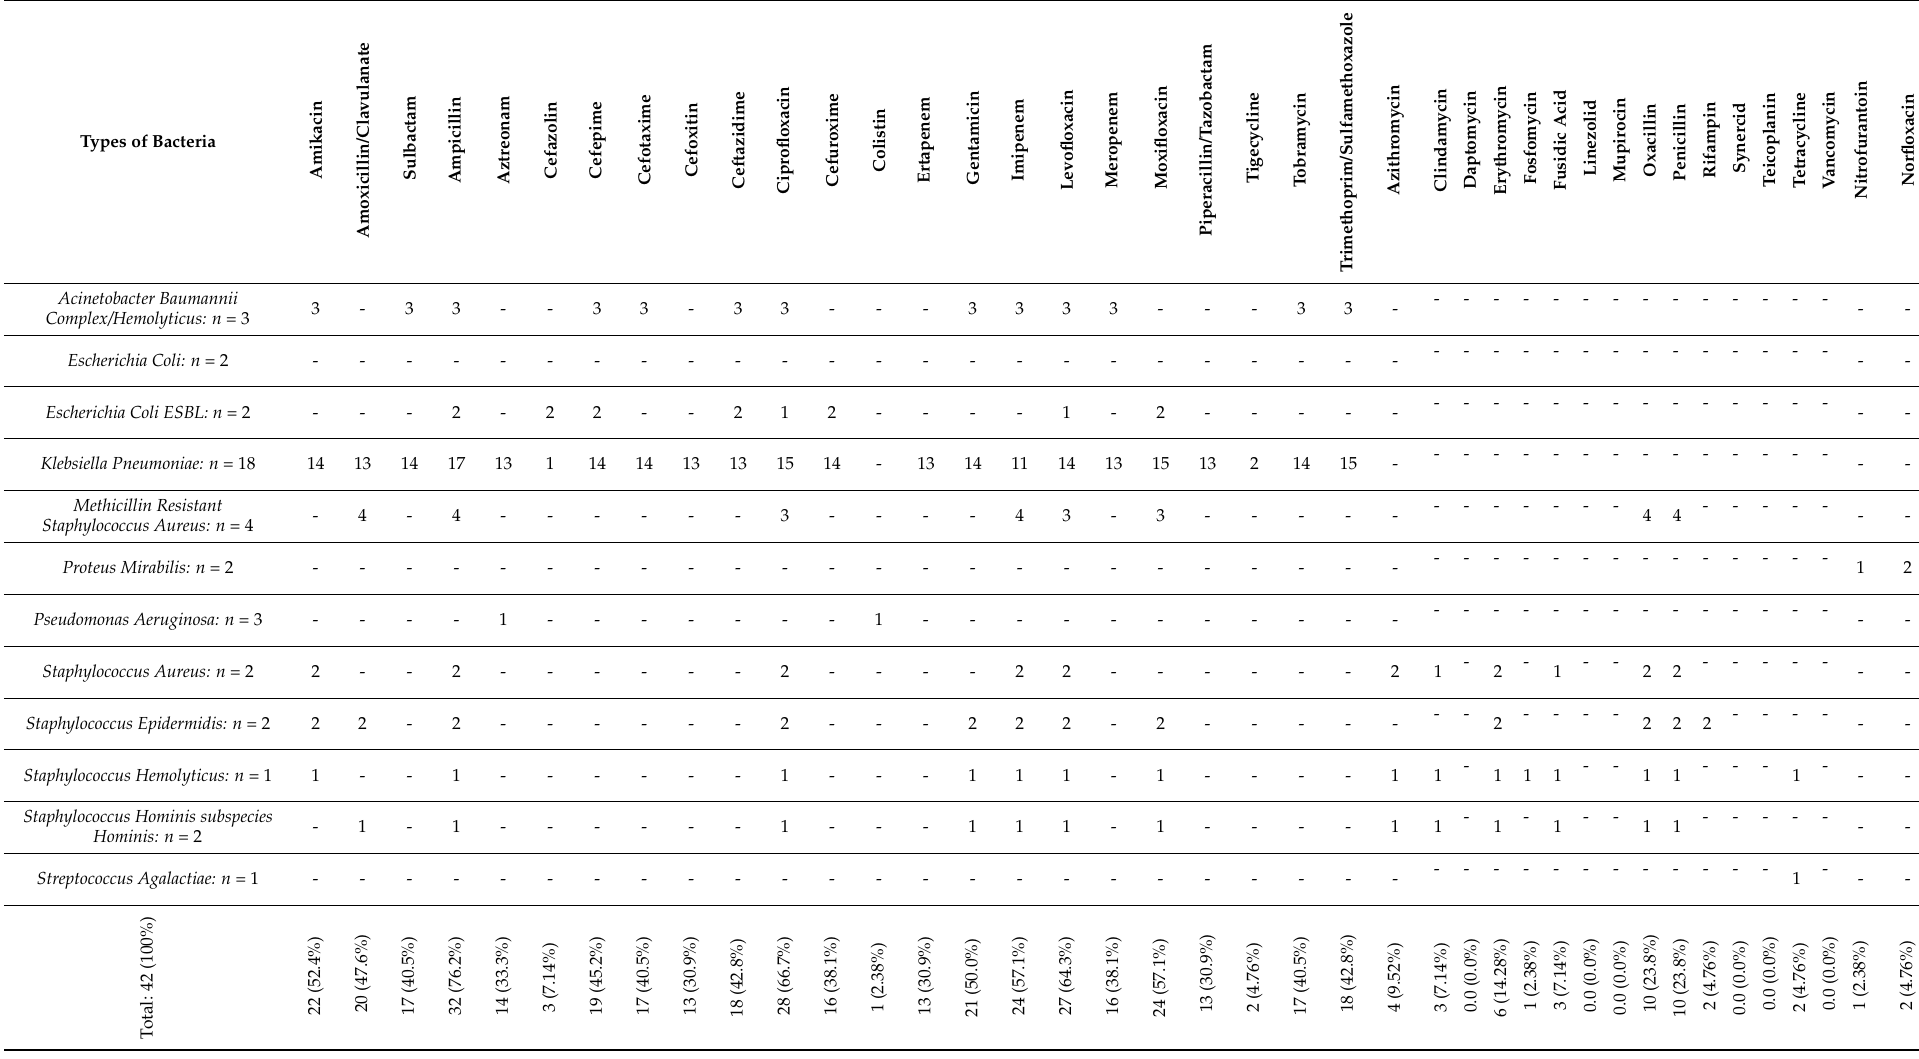
Table 4. Resistance to the most commonly used antibiotics by the types of bacteria among the study